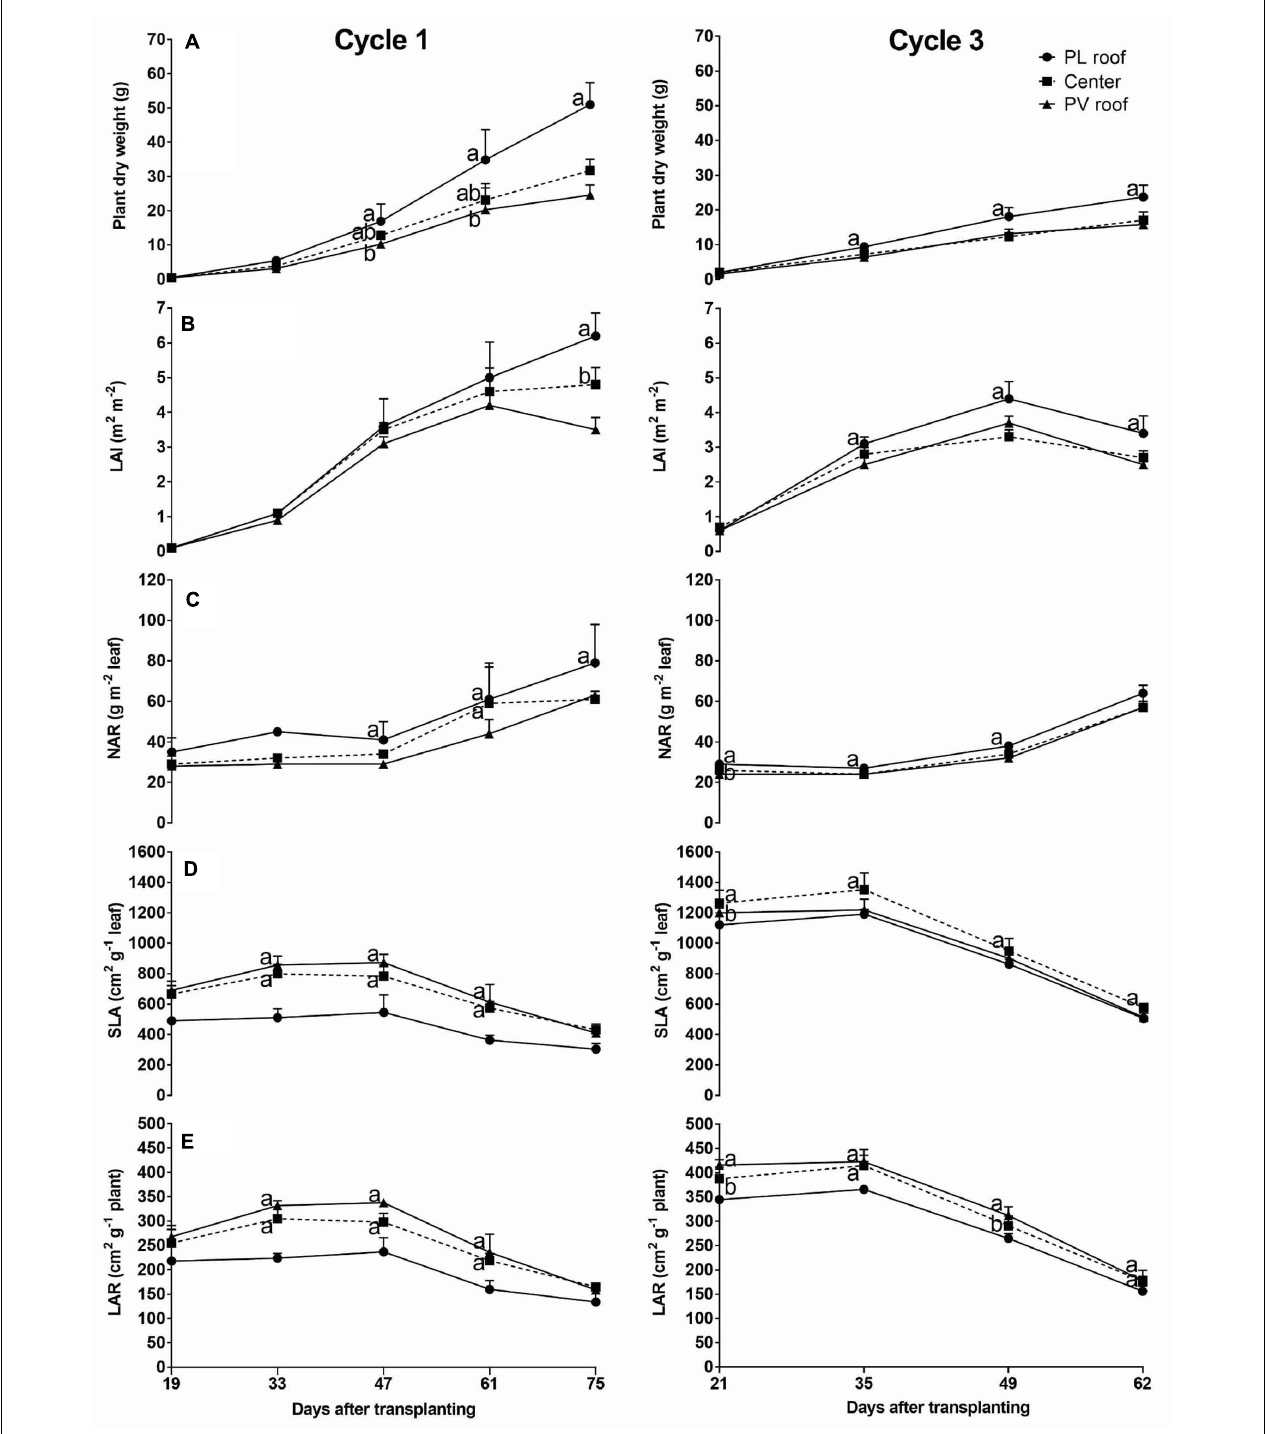
FIGURE 5 | Plant dry weight and leaf parameters on 5 days of cycle 1 (from day 19 to 75) and 4 days on cycle 3 (from day 21 to 62). Parameters reported: plant dry weight (A) , leaf area index (LAI) (B) , net assimilation rate of the leaf (NAR) (C) , specific leaf area (SLA) (D) , and leaf area ratio (LAR) (E) . Each data is the average of eight plants (two for each experimental area) taken under the PL roof (rows 2, black circles), under the center of the greenhouse span (rows 4, black squares) and under the PV roof (rows 6, black triangles). The upper bars represent the standard deviation. Symbols in the same day that do not share a letter or a missing letter are significantly different (LSD test p <